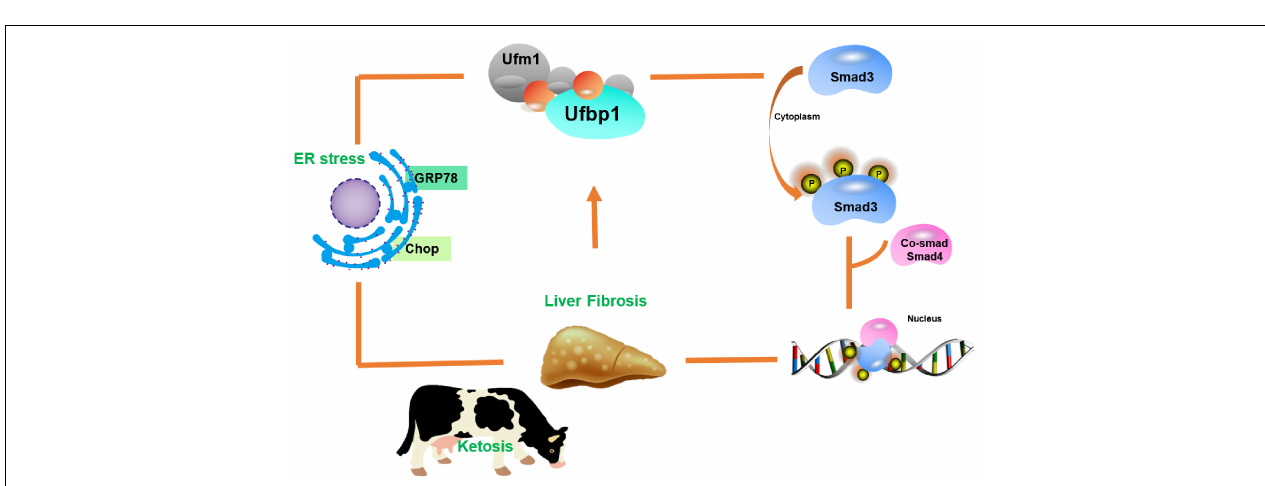
FIGURE 6 | Ufbp1 deficiency resulted in nuclear translocation of Smad3. (A) Subcellular localization of p-Smad3. (B) Nuclear and cytoplasmic extracts were blotted for pSmad3 and Smad4 of MEFs. (C) Ufbp1 overexpression affected Smad3 phosphorylation. (D) Interaction of Ufbp1 with Smad2 and Smad3 in co-immunoprecipitation assays, using IgG served as a negative control. Data are presented as means ± SEM, *** P < 0.001 ( n = 3). Scale bar = 20 µ m.